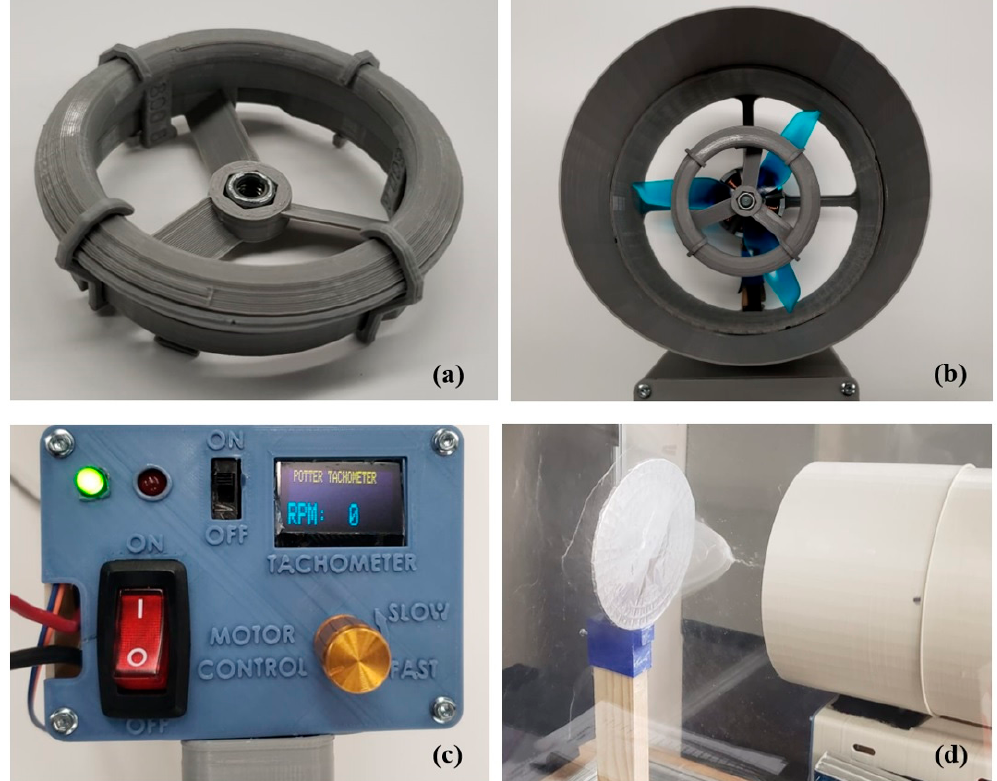
Figure 8. ( a ) Spinneret assembly and fan blade mounted on motor shaft, ( b ) 3D-printed spinneret assembly, ( c ) control panel, and ( d ) fiber mat spun with HD.